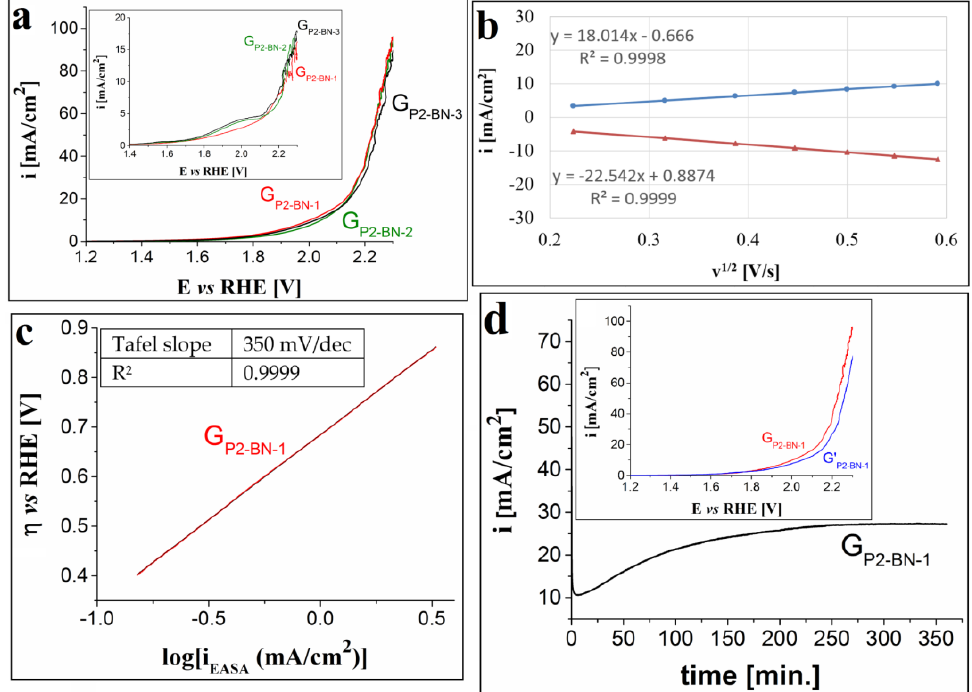
Figure 4. ( a ) Anodic LSVs recorded on the G P2-BN-1 , G P2-BN-2 and G P2-BN-3 electrodes in 1 M KOH solution, at v = 1 mV/s. Inset shows the voltammograms traced on the same electrodes, but in 0.1 M KOH solution. ( b ) The plot of the anodic and cathodic peak current densities vs. the square root of the scan rate for the G P2-BN-1 electrode. ( c ) The Tafel plot for the G P2-BN-1 electrode in 1 M KOH solution, with the current density values (i EASA ) obtained by taking into account the calculated EASA value. ( d ) i-time curve recorded on the G P2-BN-1 electrode in 1 M KOH solution and inset showing the voltammograms traced on the electrode before and after the stability test (coded as G P2-BN-1 and G’ P2-BN-1 ).